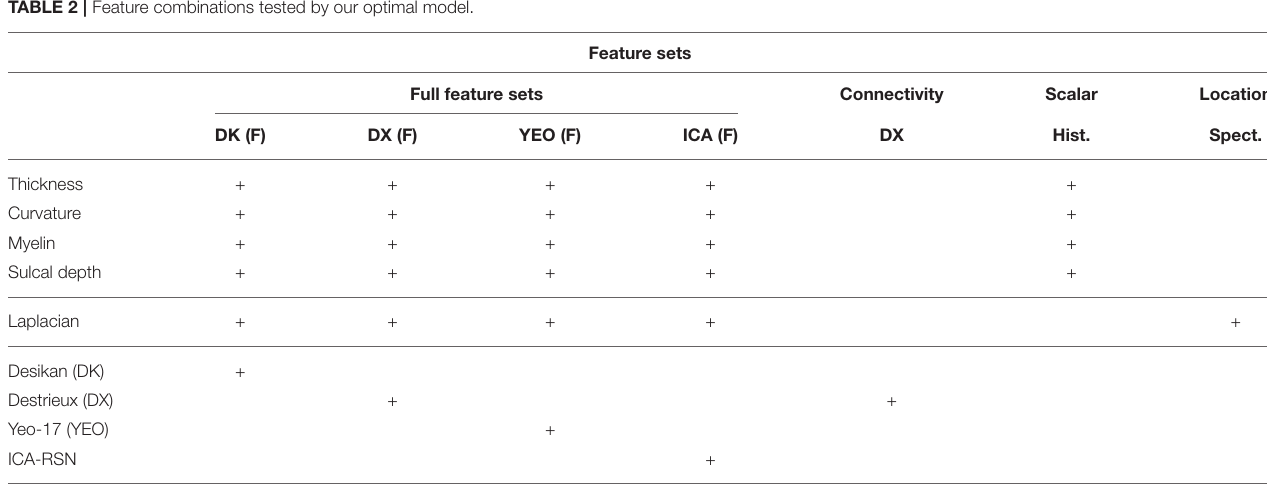
TABLE 2 | Feature combinations tested by our optimal